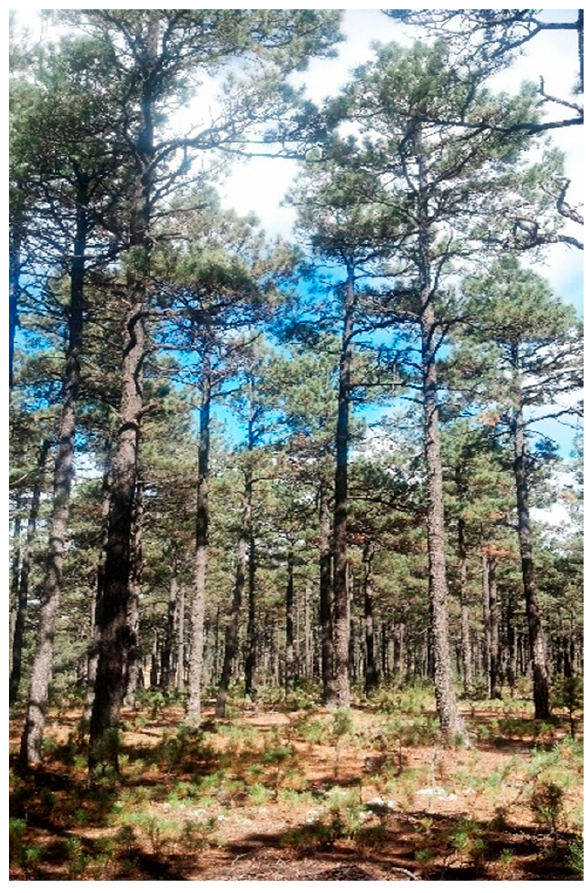
Figure 5. Managed pine-oak forest, upper Rio Conchos basin, at 21% thinning. (Photo by the author.) Prevention and conservation measures such as the opening of firebreaks and black lines for forest fire control (Figure 6). Thinning is a common treatment, that once properly done, increases the resilience of forests against global climate change, as it produces an increase in net precipitation, reduces runoff, recharges aquifers, and mitigates the effects of drought [23]. Although the results vary for each region and type of forest, 50% thinning